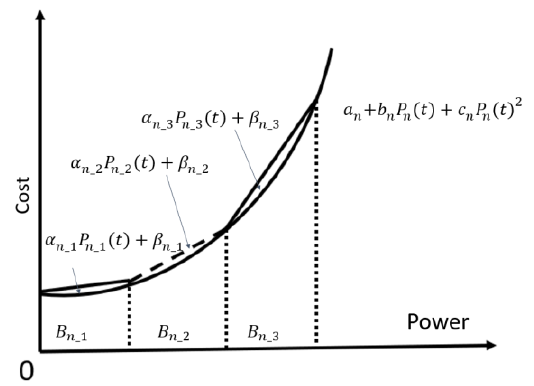
Figure 2. Typical generator cost curve with piecewise linearization.